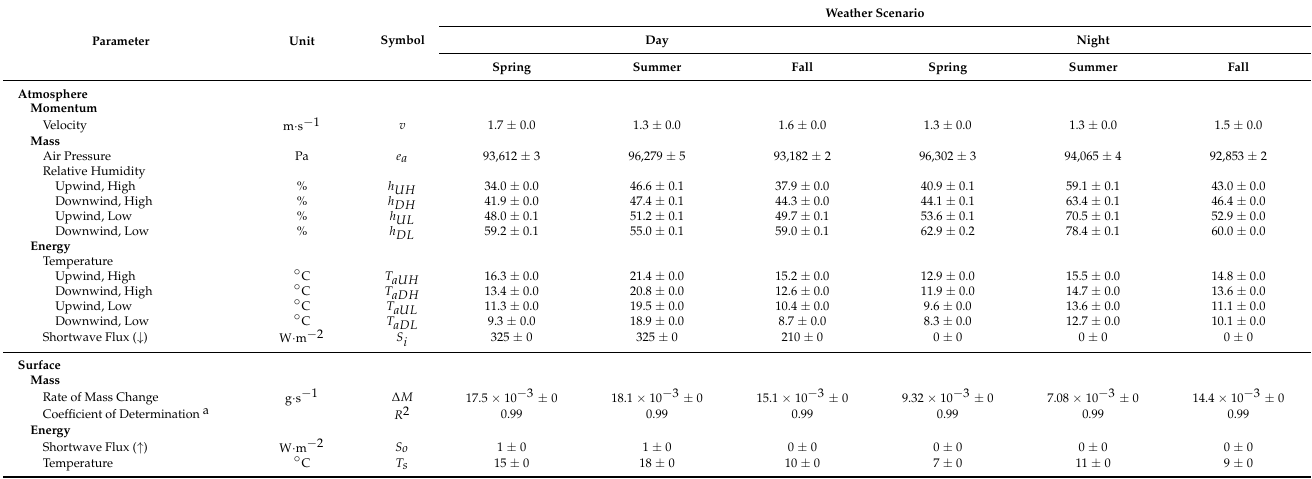
Table 2. Summary of average experimental atmospheric and water surface parameter measurements.